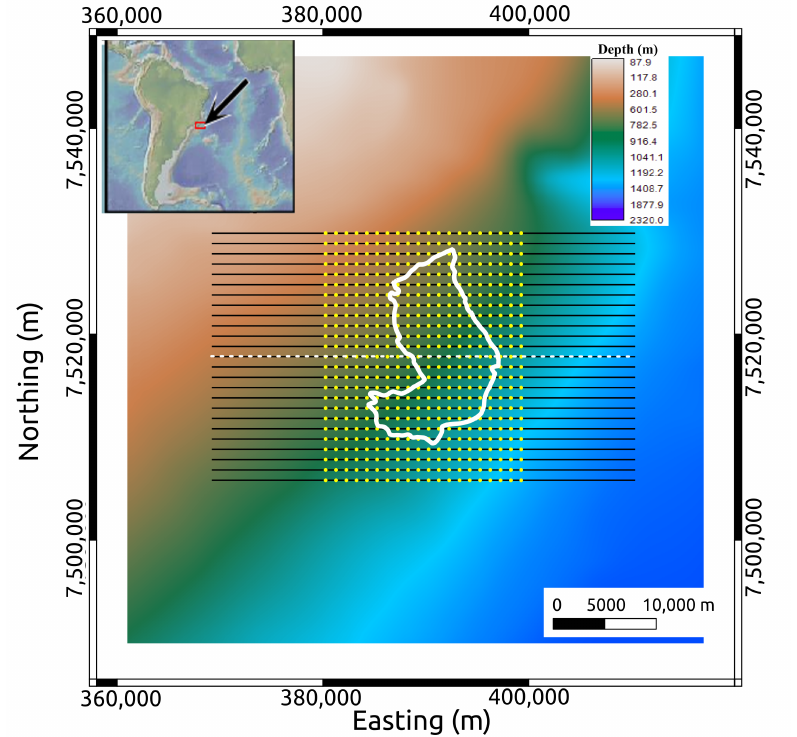
Figure 3. Geometry of the acquisition superimposed on the bathymetric map of the MR3D area. The reservoir outline is displayed as a white line. The yellow dots are receiver locations distributed in a regular grid with 1000 m spacing. The black lines are source towlines that are evenly spaced at 1000 m. Towline 04Tx013 is highlighted with the black and white striped line. Source locations are spaced every 100 m along each towline.